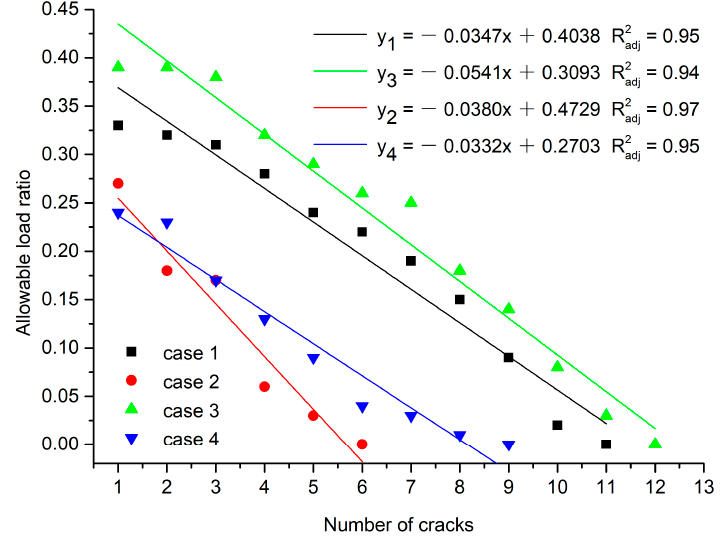
Figure 22. Curve of the allowable load ratio of cracked lining with the crack number.